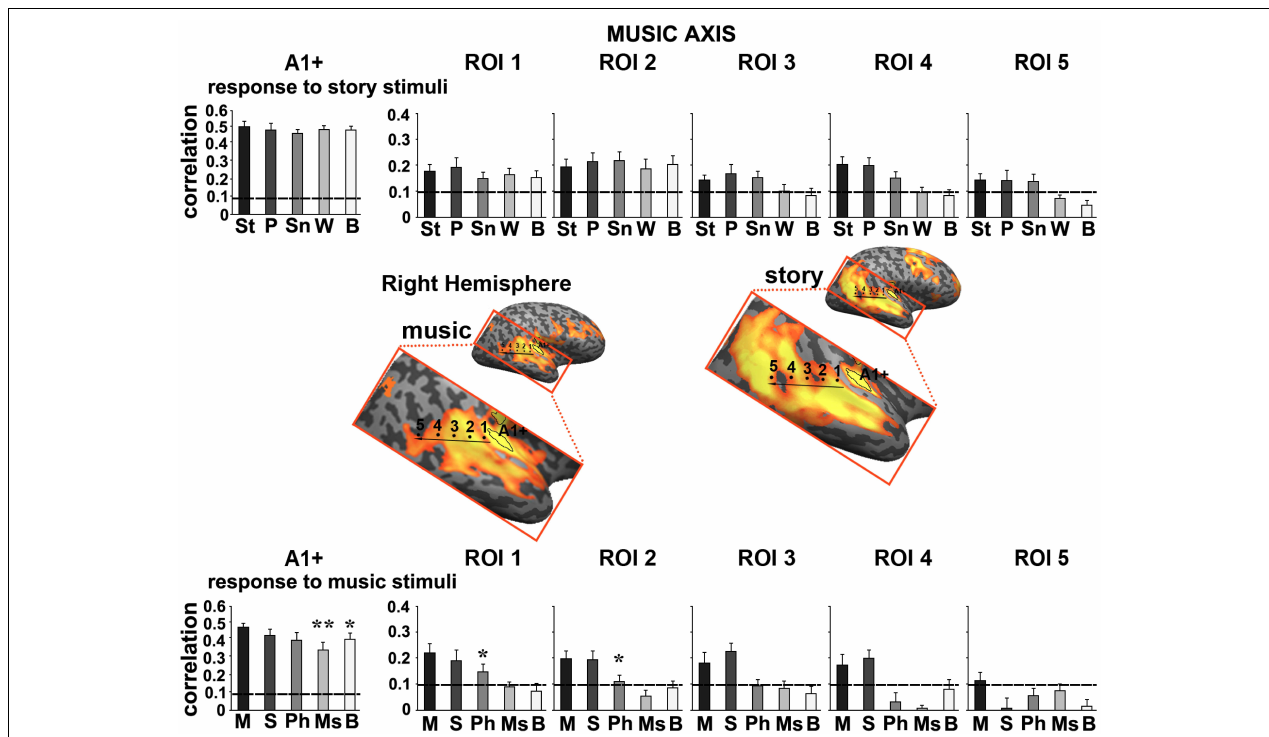
FIGURE 6 | Response reliability in ROIs defined along a “music axis” in the right hemisphere. Same format as Figure 5 . Abbreviations: St, intact story; P, paragraph; Sn, sentence; W, word; B, backward; M, intact music; S, section; Ph, phrase; Ms, measure.